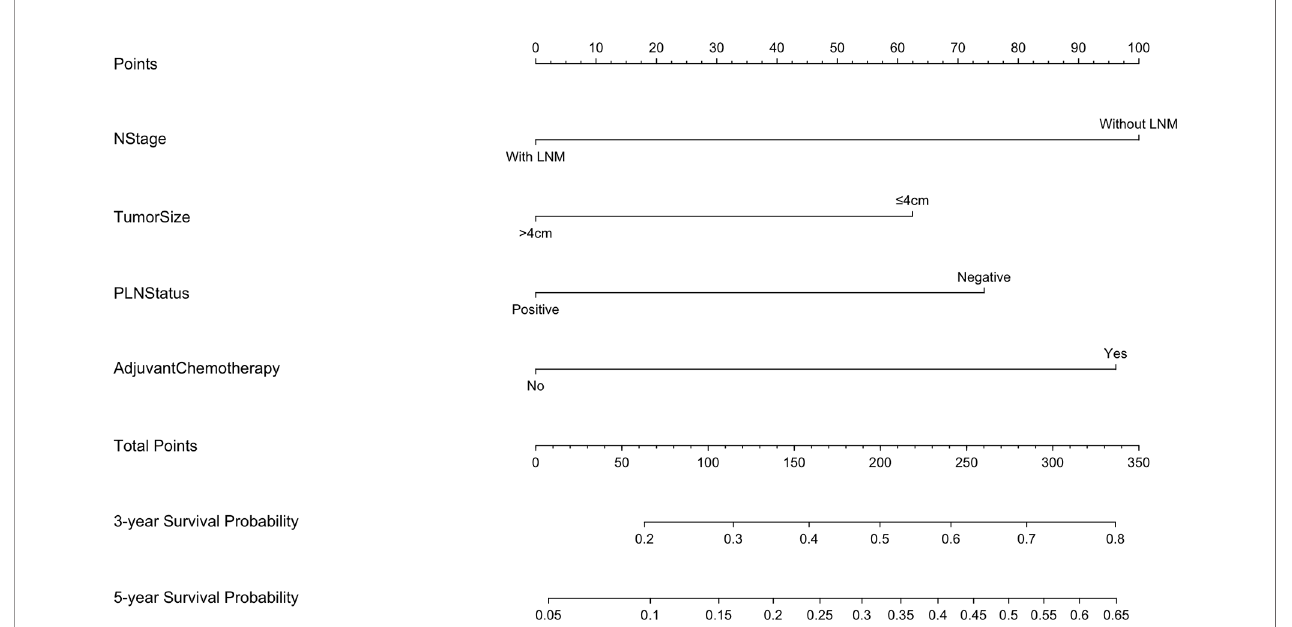
FIGURE 2 | Nomogram for predicting the 3- and 5-year survival probabilities of patients with Siewert type II/III AEG (LNM, lymph node metastasis).